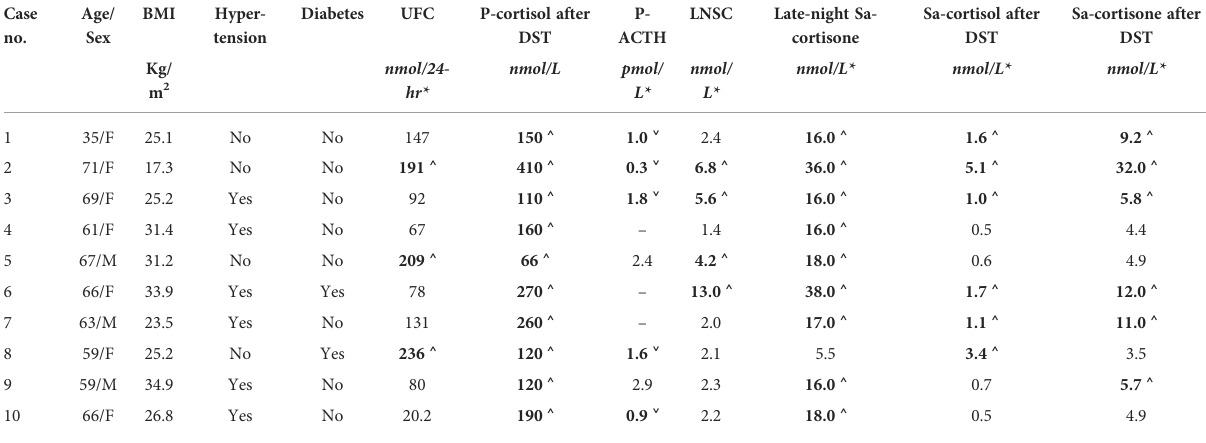
TABLE 2 Individual data on patients with adrenal incidentalomas diagnosed with autonomous cortisol secretion. Case no.